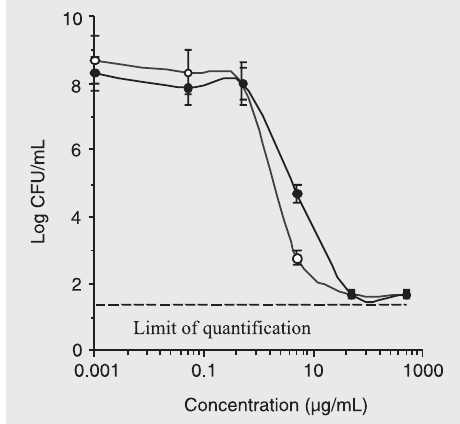
for at least three independent